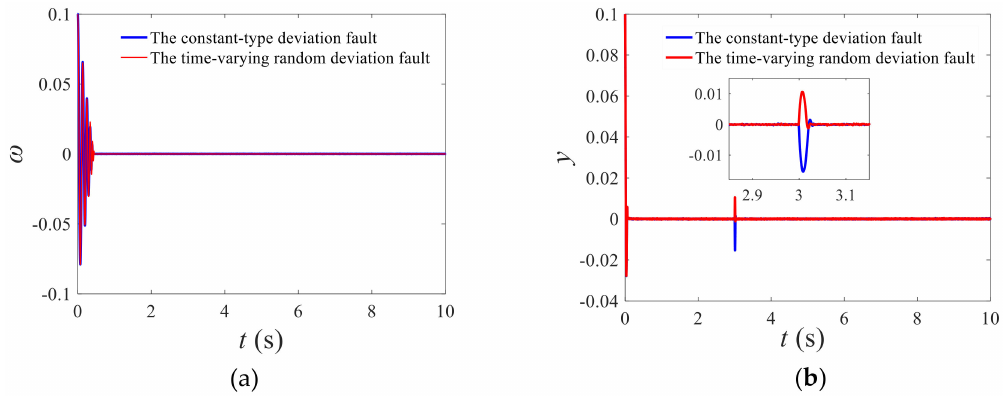
Figure 5. State trajectories of the HTGS under an actuator constant-deviation fault. ( a ) ω ( t ) − t ; ( b ) y ( t ) − t